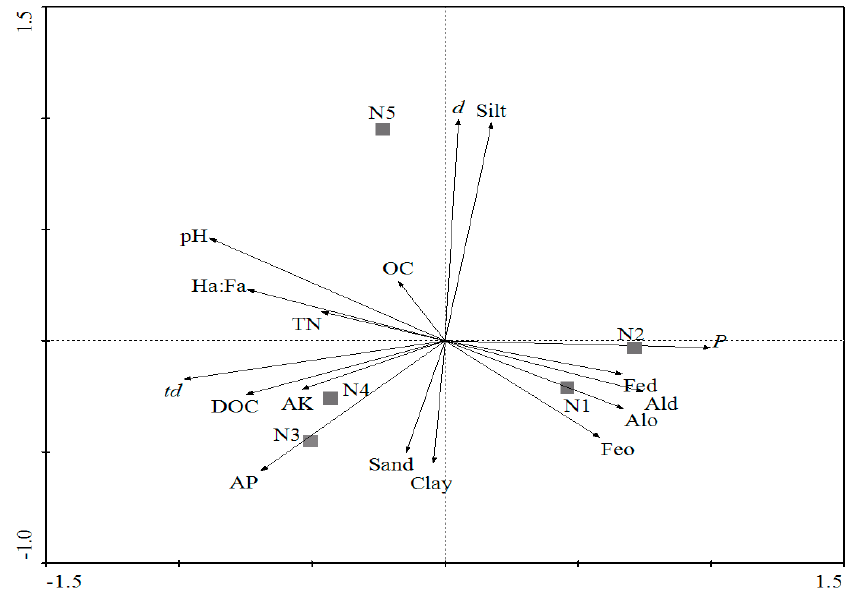
Figure 5. The redundancy analysis (RDA) of soil properties and the survival time ( t d ) of E. coli O157:H7 in the test soils.